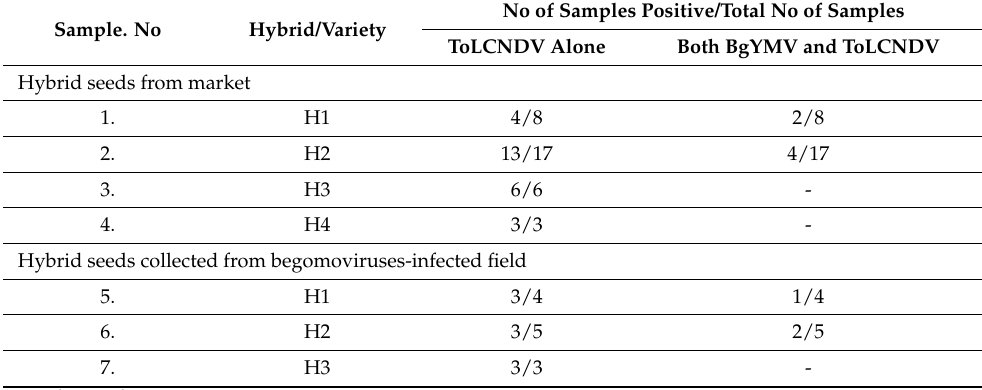
Table 2. Detection of begomoviruses in ELISA-positive embryo samples of seeds through PCR using specific primers.